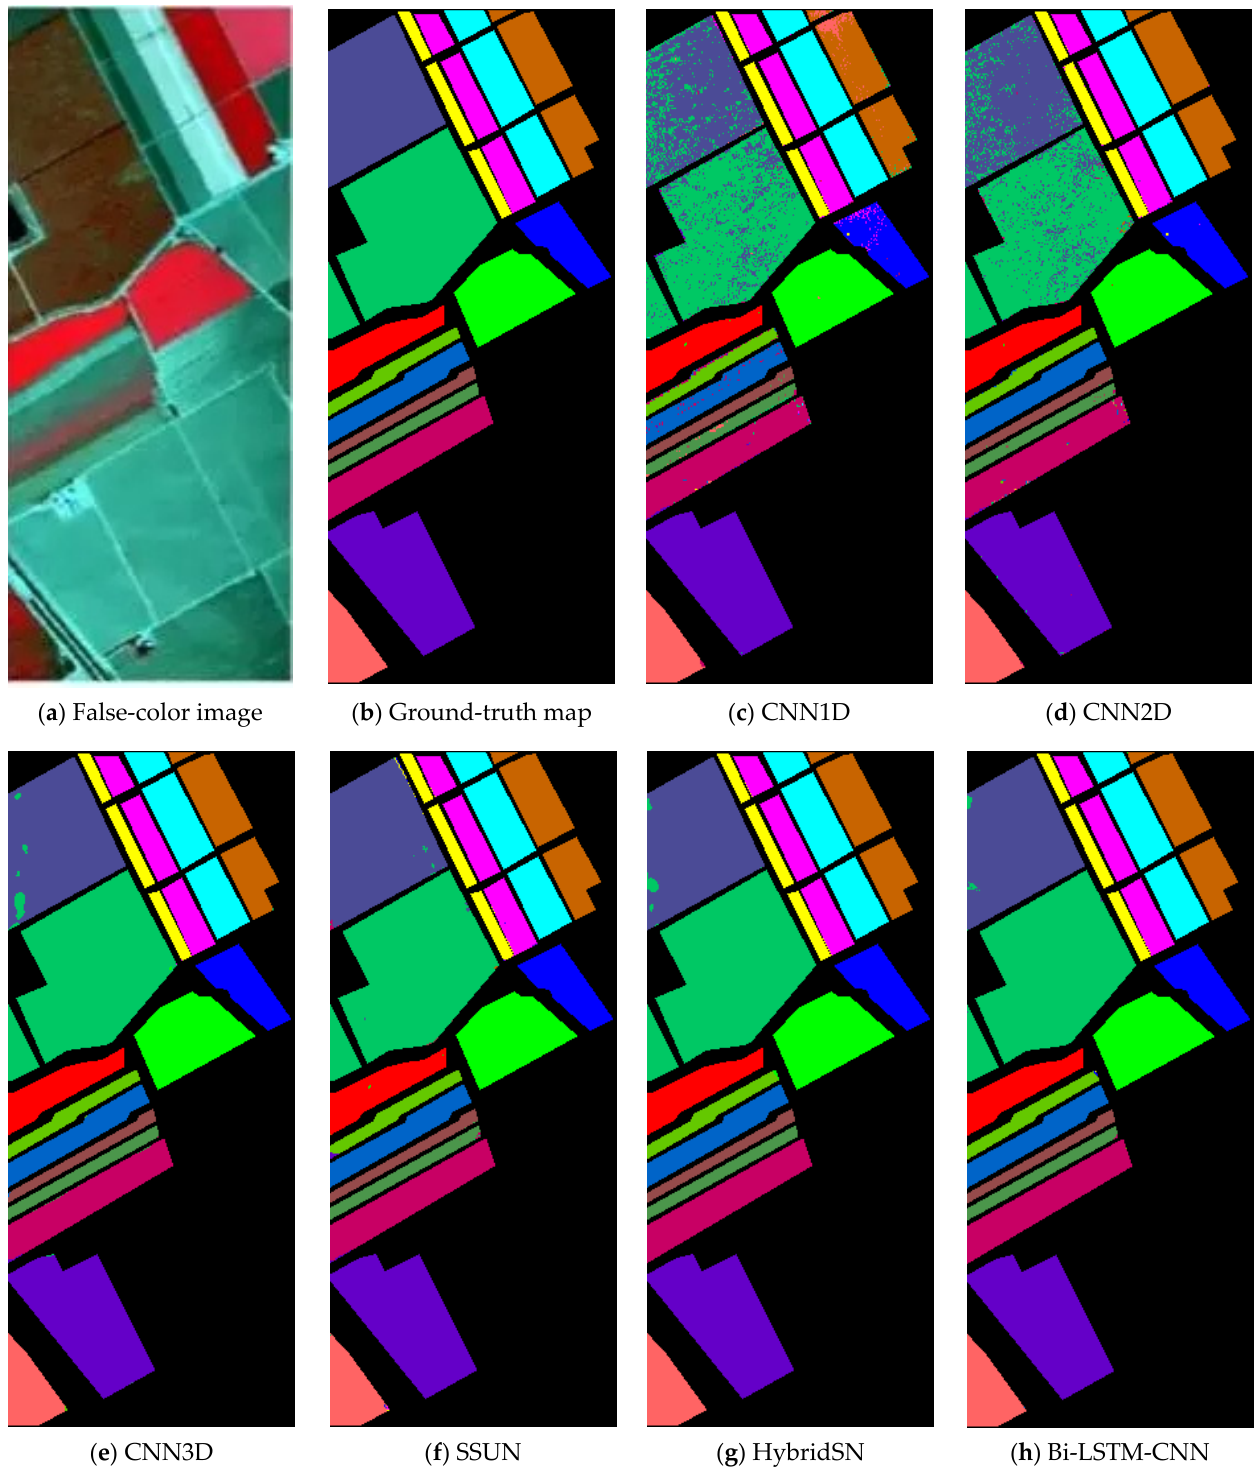
Figure 9. Classification maps for the SV dataset with 10% of training data. ( a ) False-color image; ( b ) Ground-truth map;